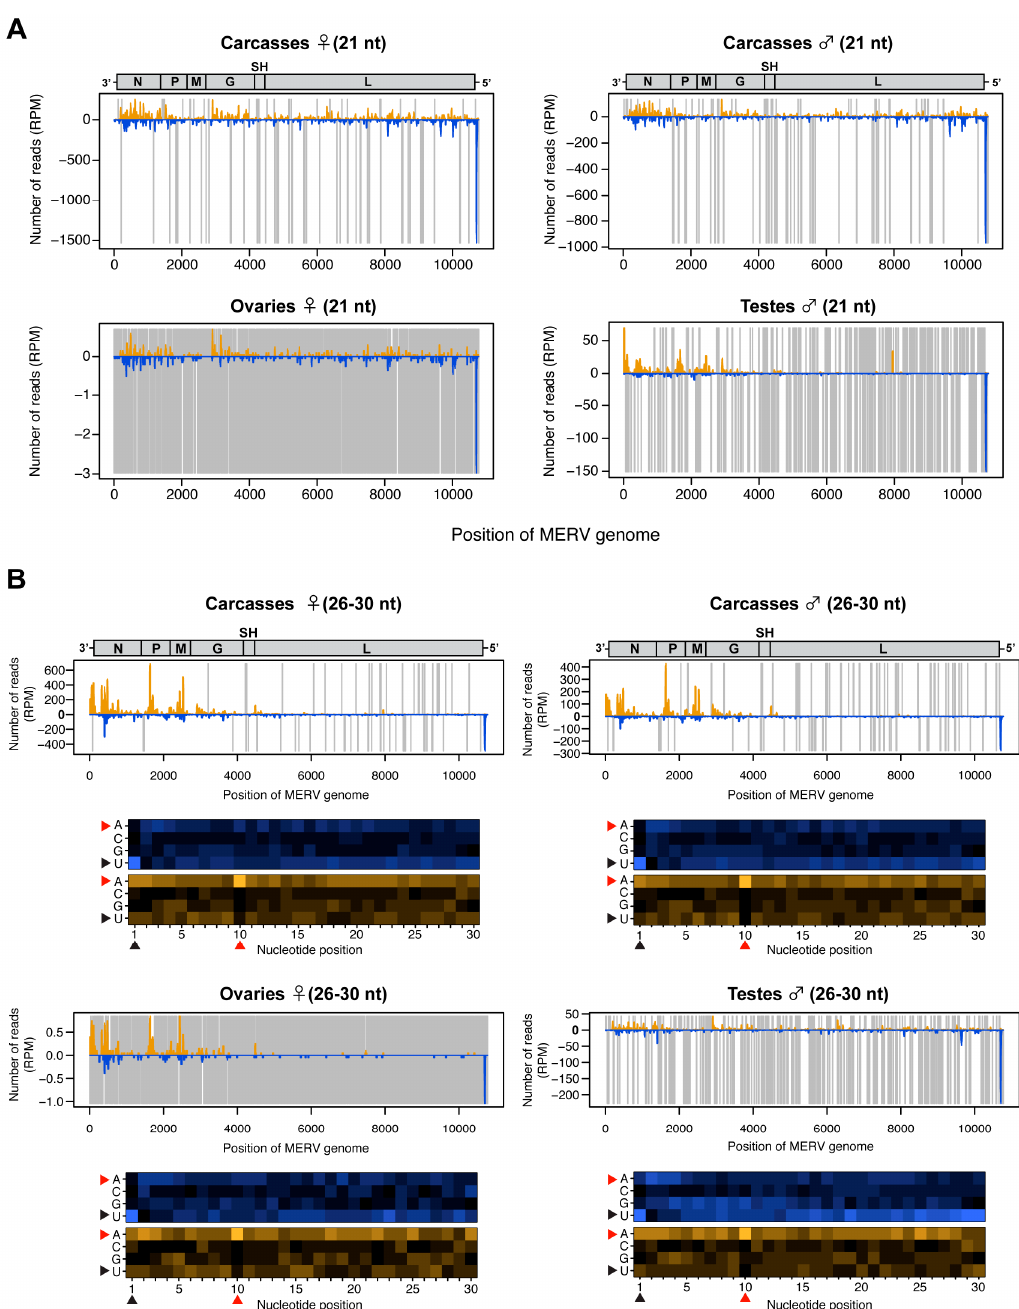
Figure 5. Small RNA responses to MERV in female and male Ae. albopictus reproductive tissues and carcasses. The distribution of siRNA (21 nt) ( A ) and piRNA-like small RNAs (26-30 nt) (upper panel, B ) mapped to the MERV genome. A schematic illustration of the MERV genome is shown on top of small RNAs mapping to the viral sequence. Yellow and blue bars represent positive- and negative-stranded reads, respectively. Regions with no coverage are indicated by gray lines. For 26-30 nt MERV-derived piRNA-like small RNAs, relative nucleotide frequency at each position is shown as a heat map (lower panel in B), in which the color intensity denotes the frequency. The black and red arrowheads point to the 1U and 10A positions, respectively.